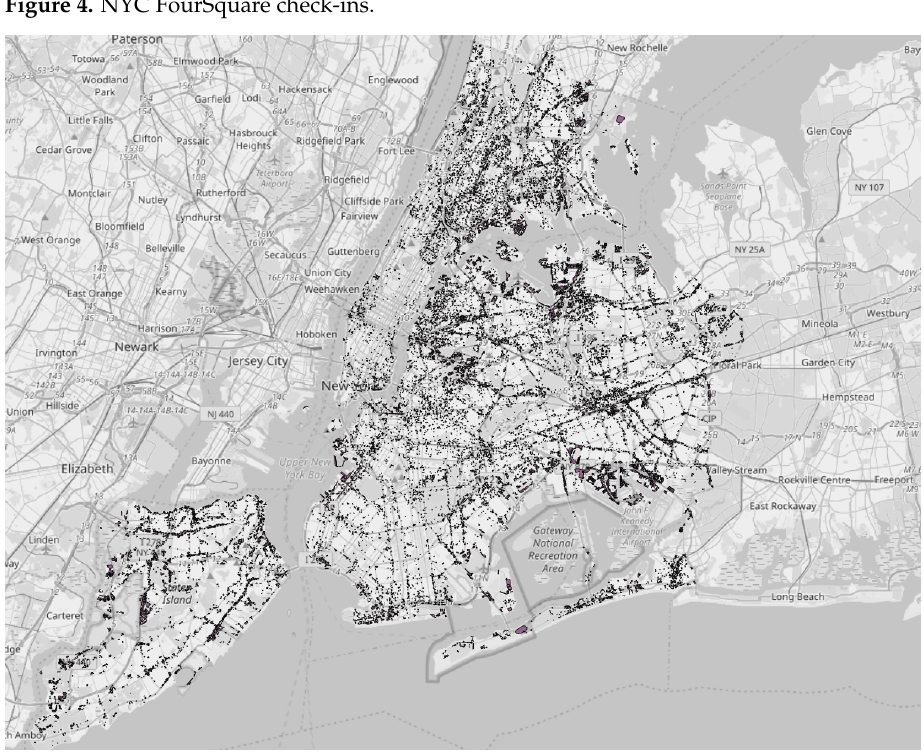
Figure 5. NYC parking